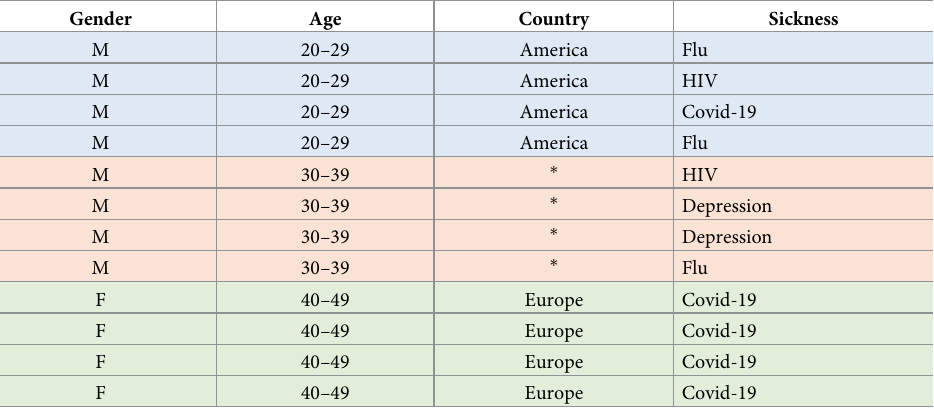
Table 2. Medical dataset in 4-anonymous